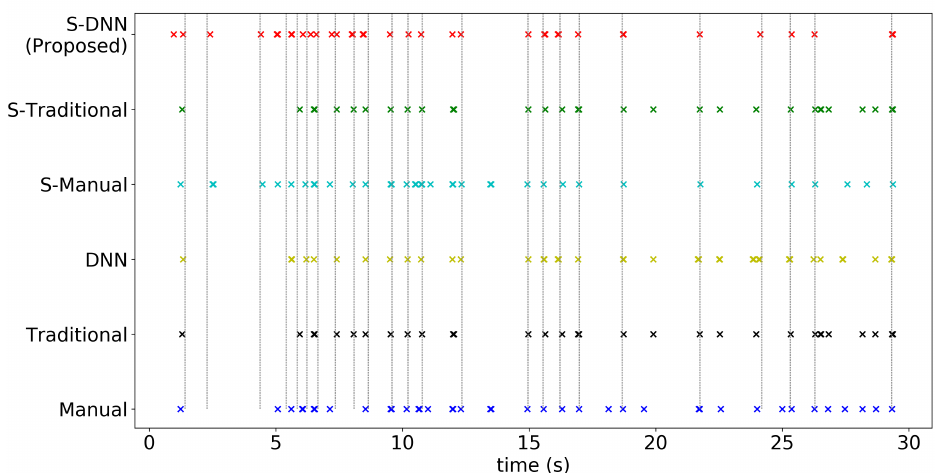
Figure A12. Prediction consistency of event counting compared with ground truths for capillary